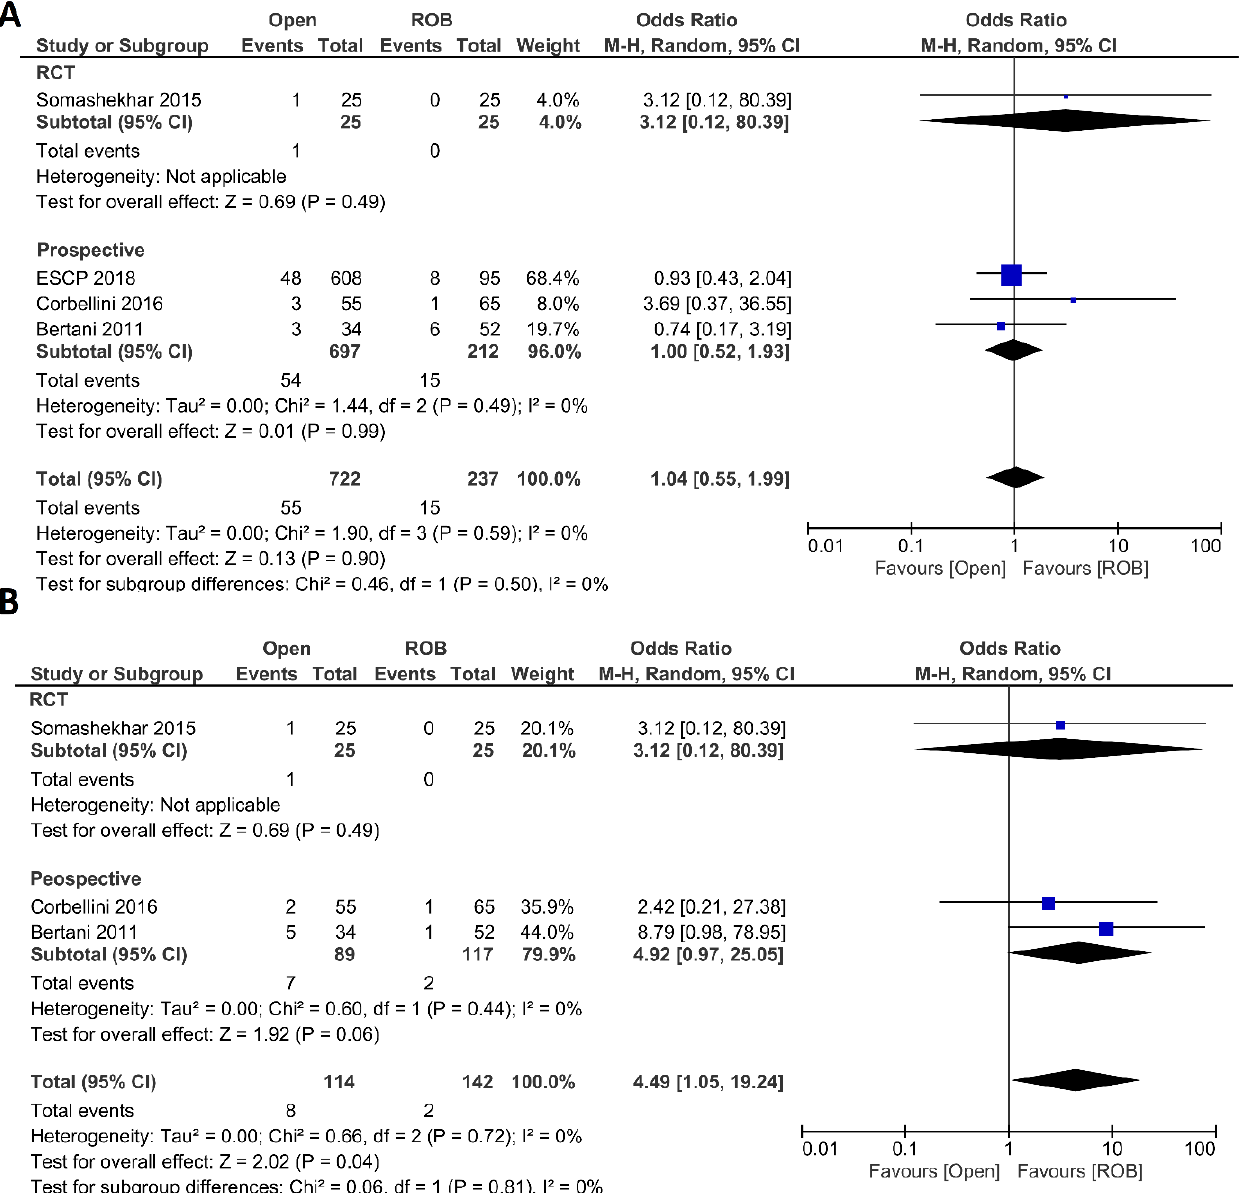
boxes representing odd ratios, green boxes representing mean differences, arrows representing 95% confidence intervals, and diamonds representing point estimates of pooled odd ratios or mean differences).